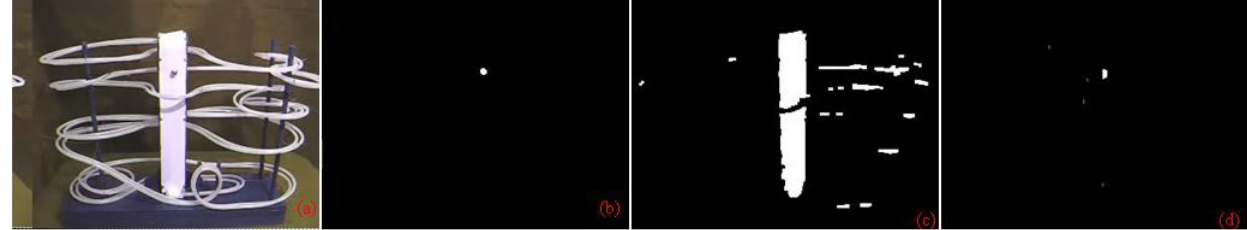
Figure 11. Simulation results for the grey world algorithm. ( a ) Input ( b ) Ground truth ( c ) Method: Renno et al . ( d ) Zulkifley et al .